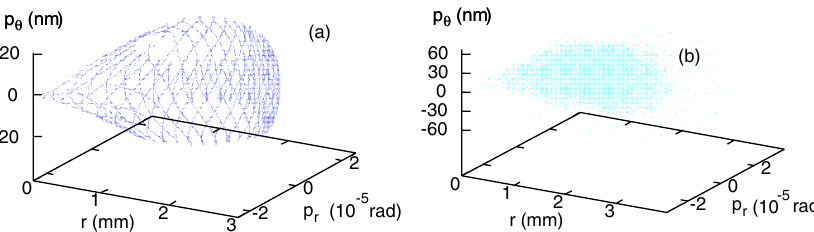
(cid:1) p FIG. 15. (Color) Poincare´ plot in r (cid:1) p space. Plots (a) and (b) are near integrable ( (cid:12) (cid:5) 0 : 27 ) and stochastic ( (cid:12) (cid:5) 0 : 27 ) r (cid:11) trajectories, respectively. The trajectories of blue and light blue correspond to those of Fig. 14 plotted with the same